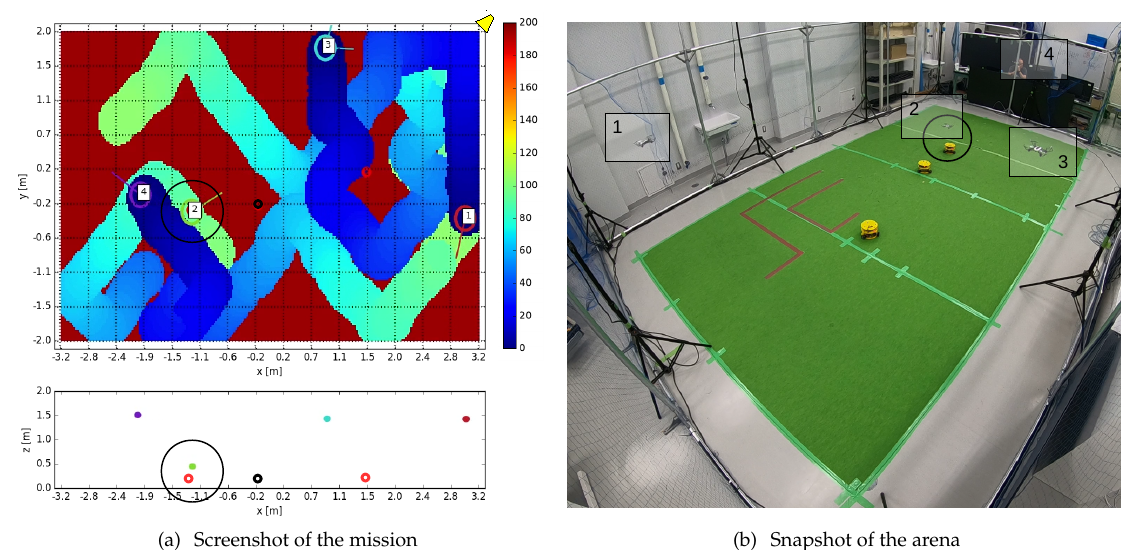
Figure 14. Screenshot of the surveillance mission at a certain instant. In Figure 14a, in the upper graph, the position of each quadcopter and ground robots in the xy plane has been represented. In the background, the age of the cells. Each of the 4 agents has been labeled with its ID. The position on the camera has been indicated with a yellow trapezoid. In the lower graph, the position in the xz plane. Friendly intruders have been plotted in black; enemy intruders in red. Note that agent number 2 is observing (flying at a low altitude) one of the enemy intruders. In Figure 14b, a snapshot of the arena.